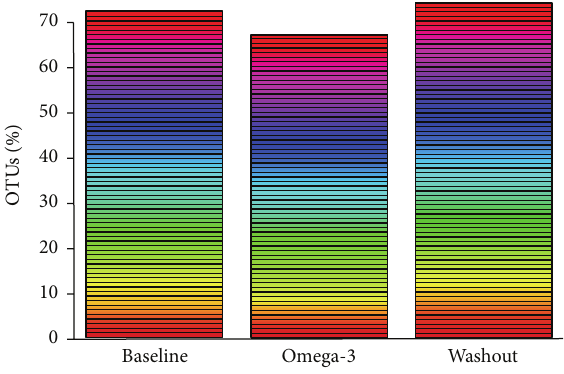
Figure 2: Rarefaction curve of the gut microbiota species at baseline, after omega-3 rich diet, and at washout. OTUs: operational taxonomic